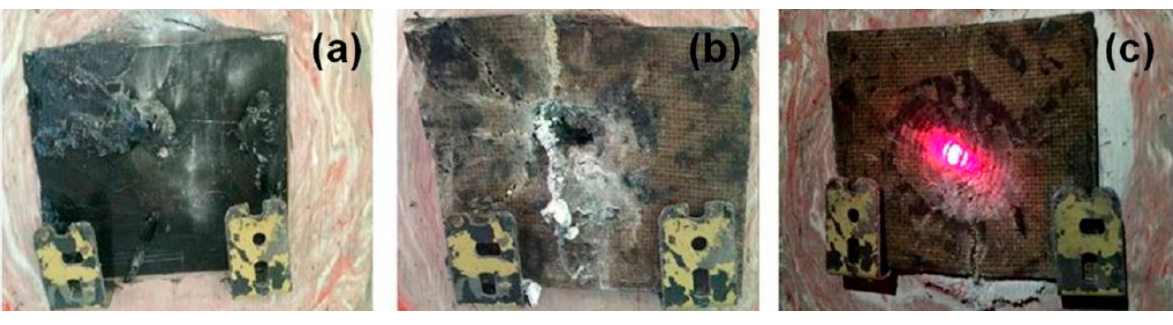
Figure 16. Images of jute fabric at ( a ) 10, ( b ) 20, and ( c ) 30 vol% as second layer in the multi-layered amour system (MAS) polyester composite. (Adapted with copyright permission from Monteiro et al. [117]).